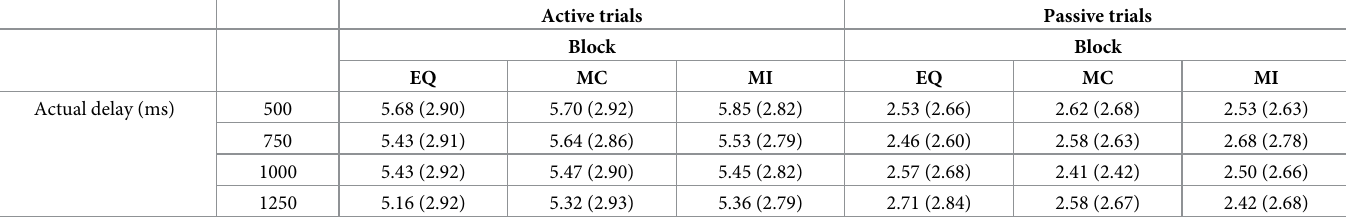
Table 4. Means (SD) for the sense of agency ratings (score between 1–9) in relation to block (EQ, MC, MI) and delay (500, 750, 1000 or 1250ms) for the active and passive